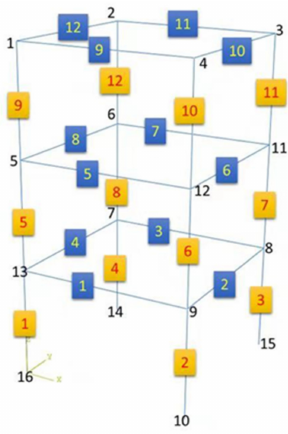
Figure 2. The model and the number of beams, columns, and joints.